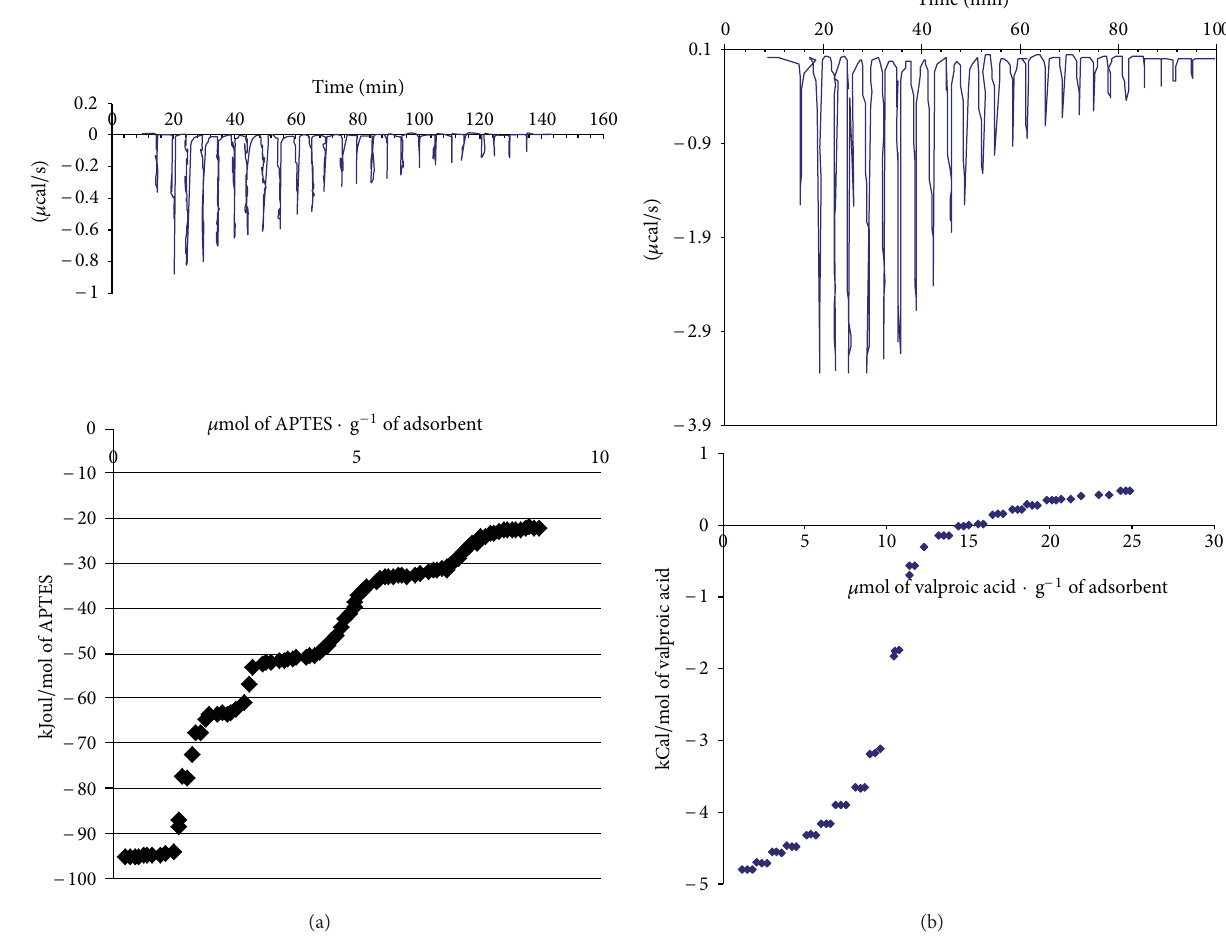
F 9: ermograms for the titration of (a) APTES and (b) valproic acid solution on SBA-15-AP(1:15) at 25